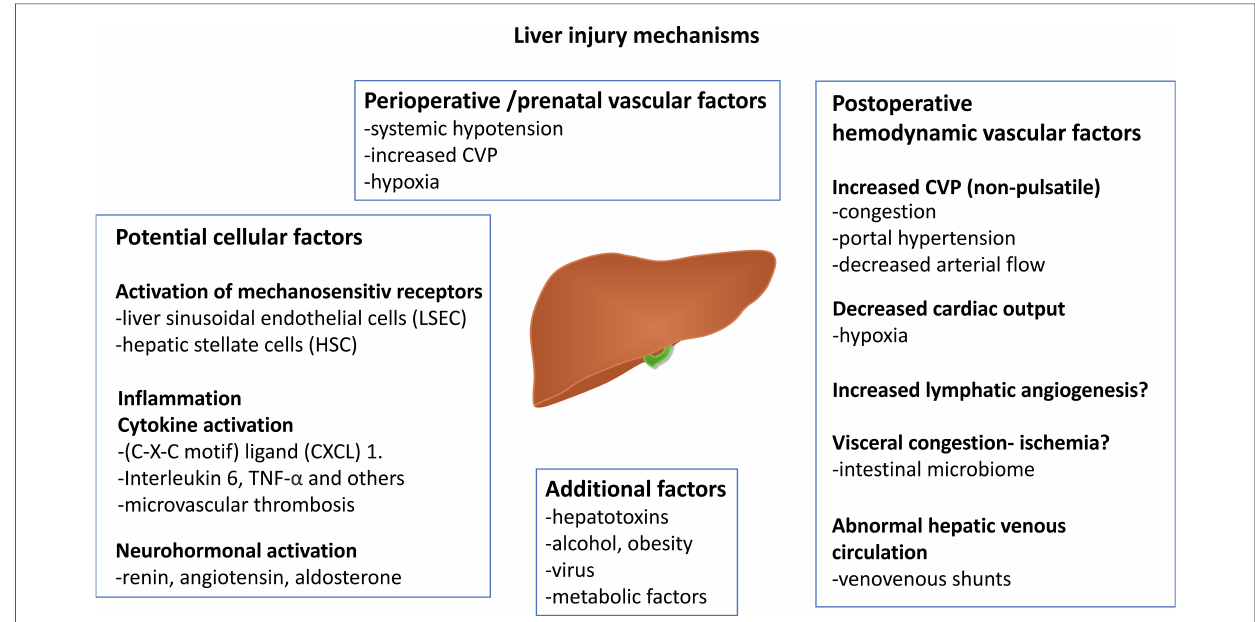
FIGURE 3 Figure displaying the most common proposed mechanisms in fl uencing FALD development. Neutrophil chemotactic chemokine (C-X-C motif) and tumor necrosis factor- α (TNF α ). A part of the illustration is created by Michael Bjaanes in collaboration with the Department of Pediatric Cardiology and